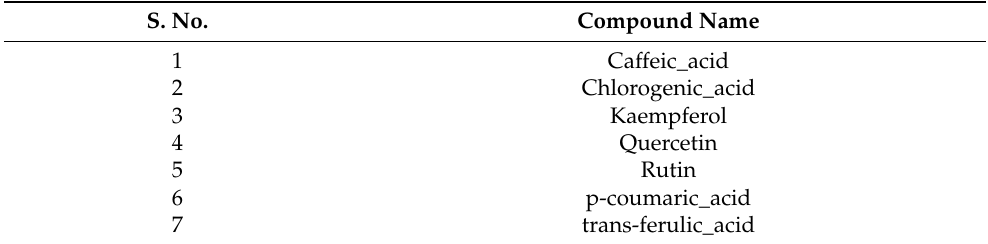
Table 2. List of selected compounds from C. papaya . S.